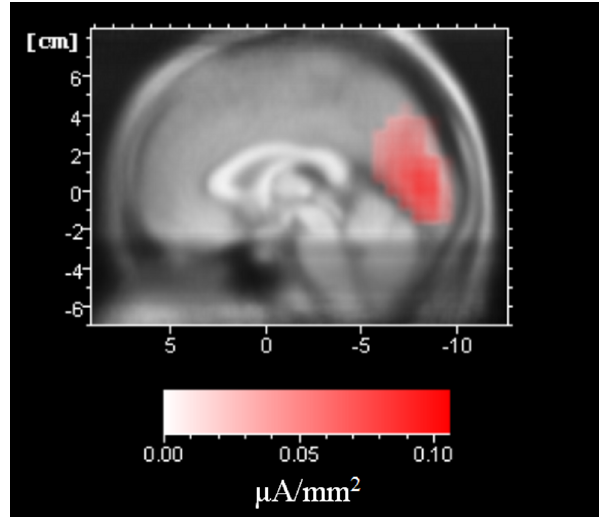
Figure 2. Alpha-band source localisation from the averaged signal across the 15 subjects using LORETA.